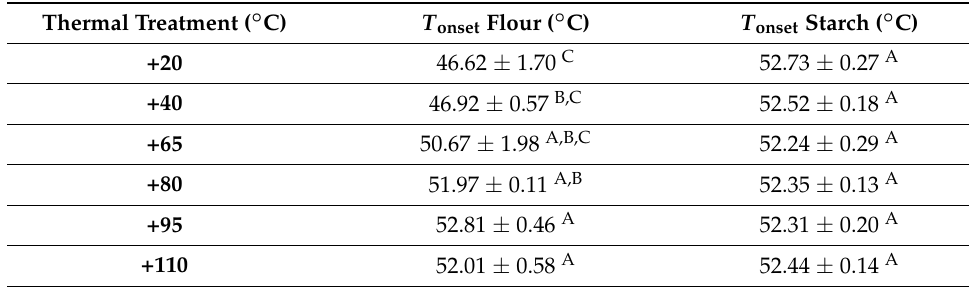
Table 1. Mean ( ± SD) gelatinization onset T onset of thermally treated (TS) wheat flour and wheat starch. SD = standard deviation; n =